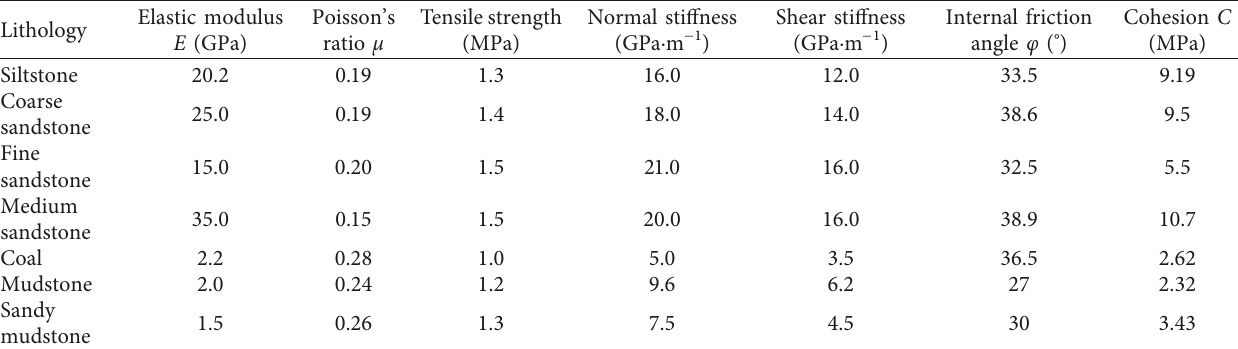
F IGURE 7: Structural schematic diagram of the model. Table 1: Physical and mechanical properties of rock